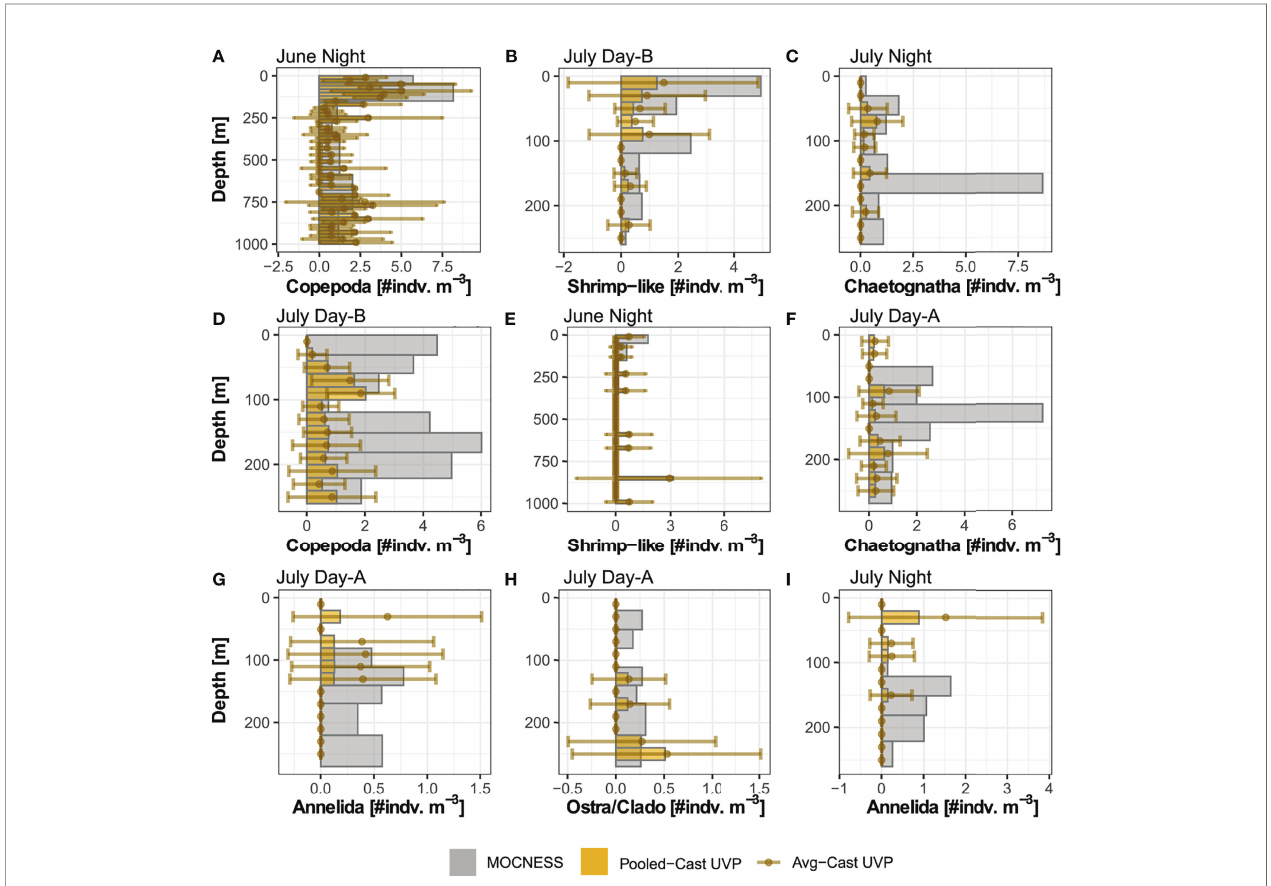
FIGURE 4 | Selected pro fi les of taxa density estimates by the MOCNESS, pooled-cast UVP, and average-cast UVP calculations. Pooled-cast UVP is shown as bars while average-cast UVP is shown mean points with standard deviation. MOCNESS depth-bins are determined by net deployment while UVP bins are 20m Pro fi les are selected to show (A – C) cases where the vertical pattern of plankton shown by the MOCNESS is captured by the UVP, (D – F) cases where the UVP does not emulate the MOCNESS, and (G – I) cases of annelids and ostracod/cladocerans. (A) Copepod density estimates from June night. (B) Shrimp-like density estimates from July Day-B. (C) Chaetognath density estimates from July Night. (D) Copepod from July Day-B. (E) Shrimp-like density estimates from June night. (F) Chaetognath density estimates from July Day-A. (G) Annelid density estimates from July Day-A. (H) Ostracod/Cladoceran density estimates from July Day-A. (I) Annelid density estimates from July night. All pro fi les are available in Supplemental Figure 6